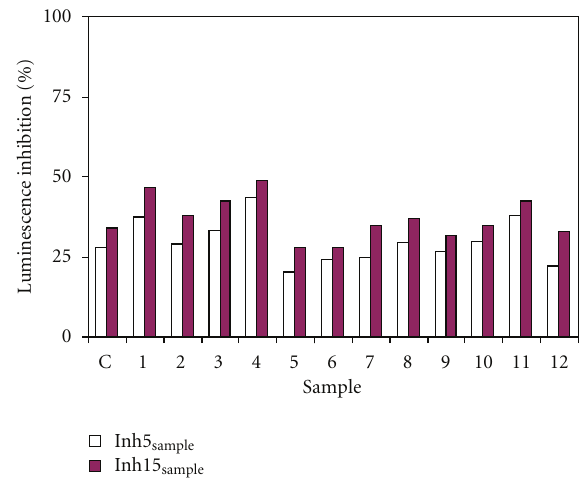
Figure 2: Luminescence inhibition (%) of the water extract in the sediment analysed (C = control sample).